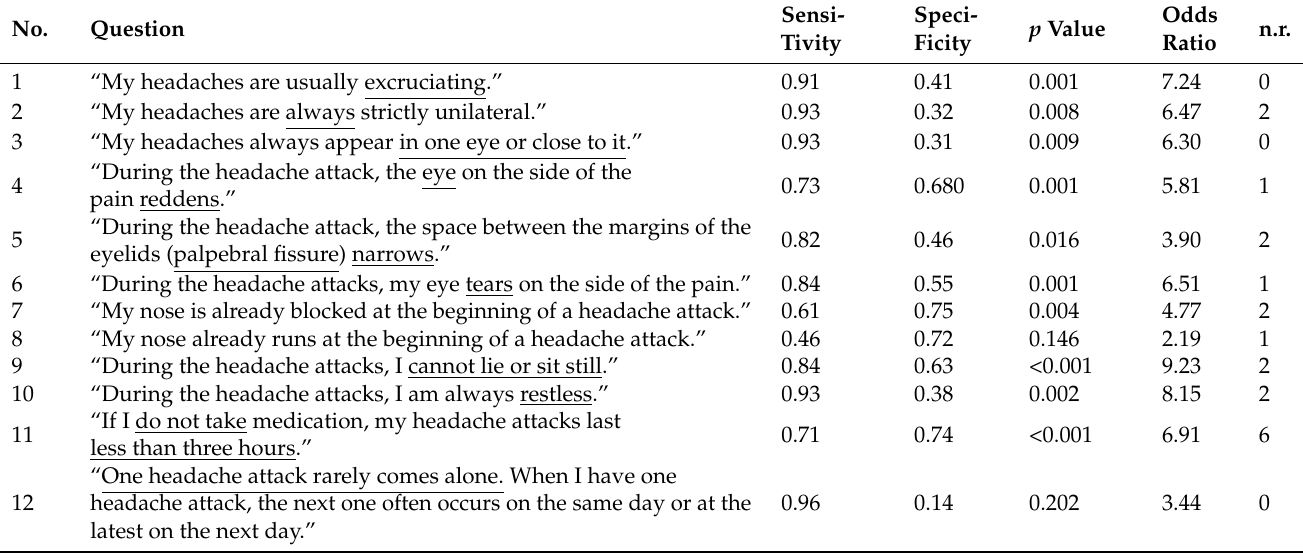
Table 1. Analysis of the discriminatory power of all 22 diagnostic questions; except item 21, we assumed the answer “yes” to indicate a cluster headache; the underlines were part of the original questionnaire to draw attention to the distinguishing feature; n.r.—not